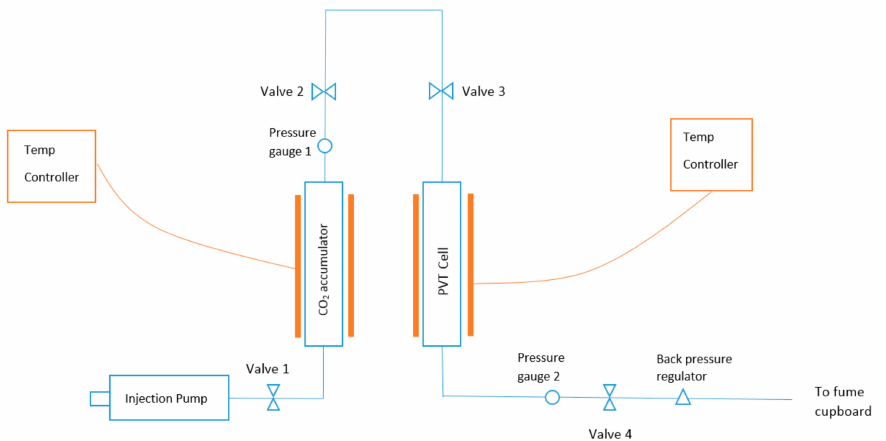
Figure 1. Schematic of exposure